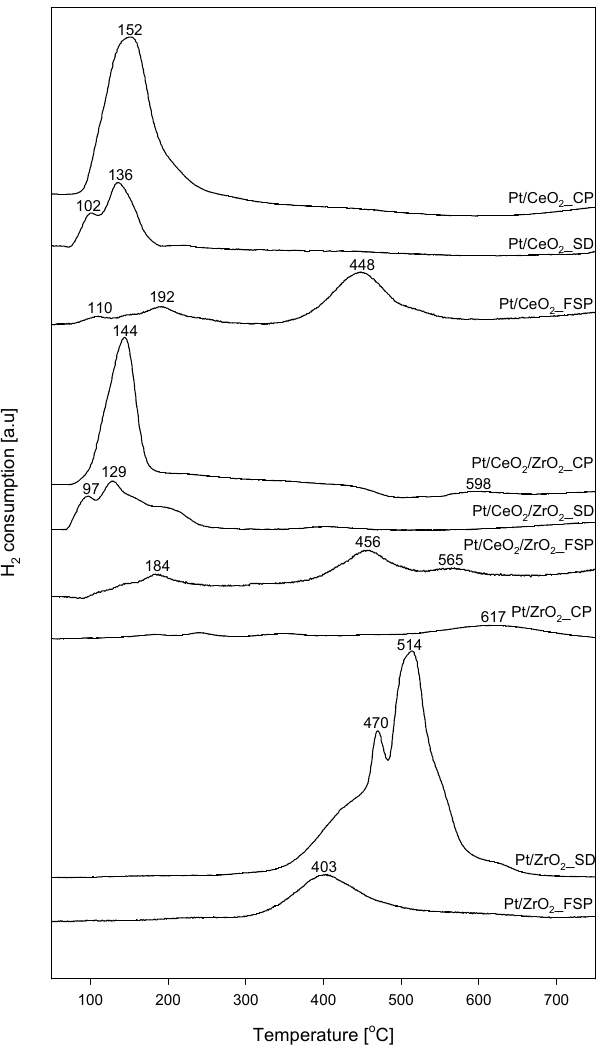
Figure 2. TPR profiles for all catalysts. Reduction in 7% H 2 /Ar using a heating rate of 10 °C/min.